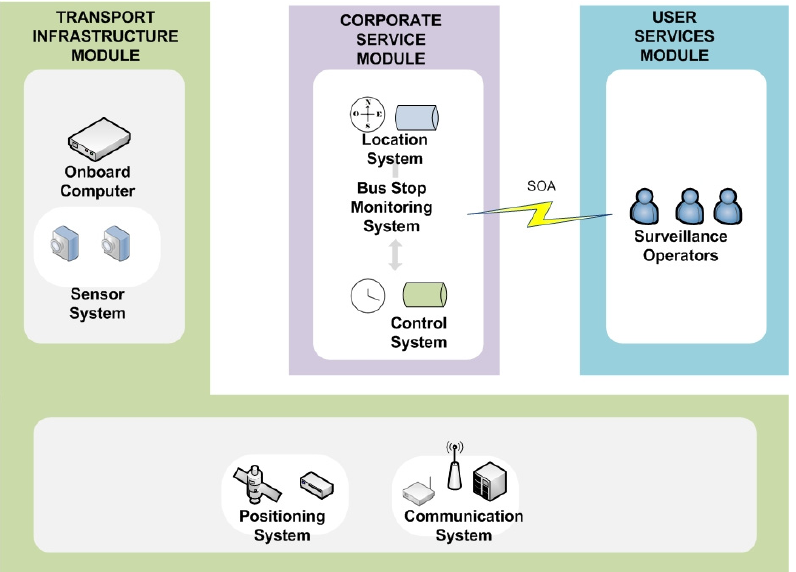
Figure 7. Overview of the bus stop monitoring system.